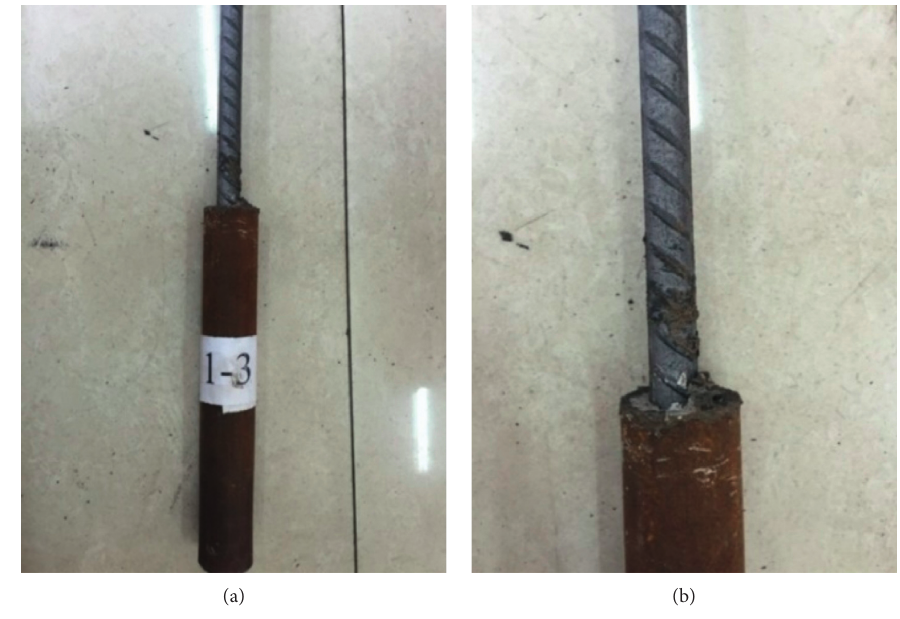
Figure 7: Specimen failure schematic diagram.